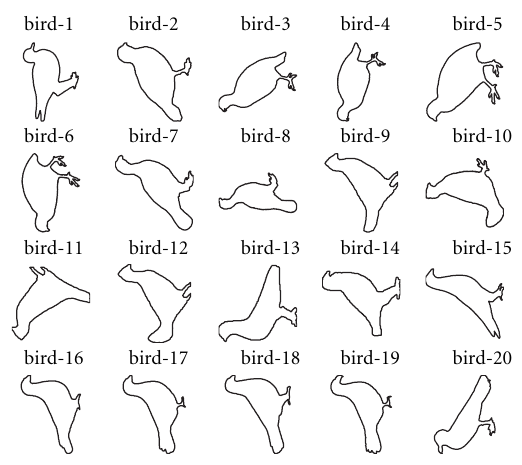
Figure 2: Bird contours from the MPEG-7 shape test set B.